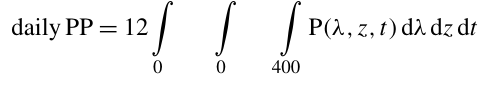
algorithm MedOC4 (Mediterranean Ocean-Colour 4